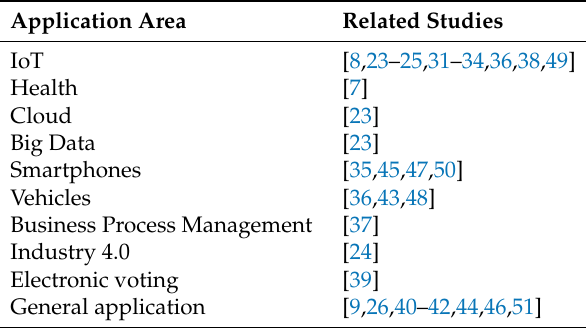
Table 4. Relationship between areas of